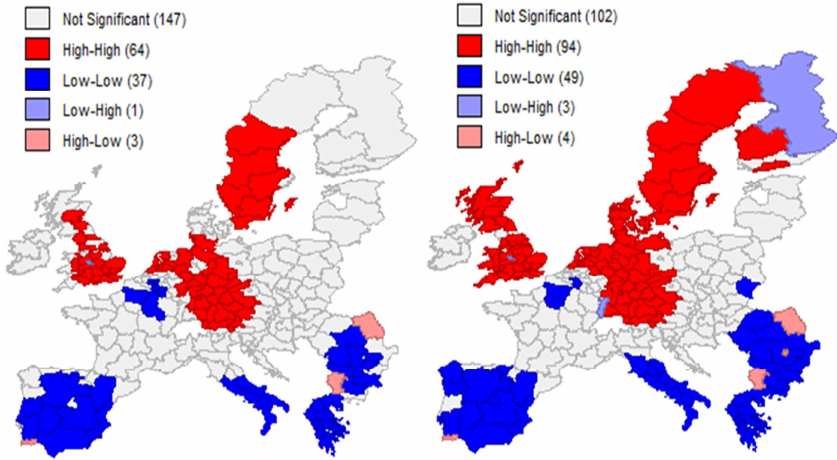
Figure 5. LISA cluster map of employment rate in 2016 — spatial weights: queen (left) and 8 — nearest neighbours